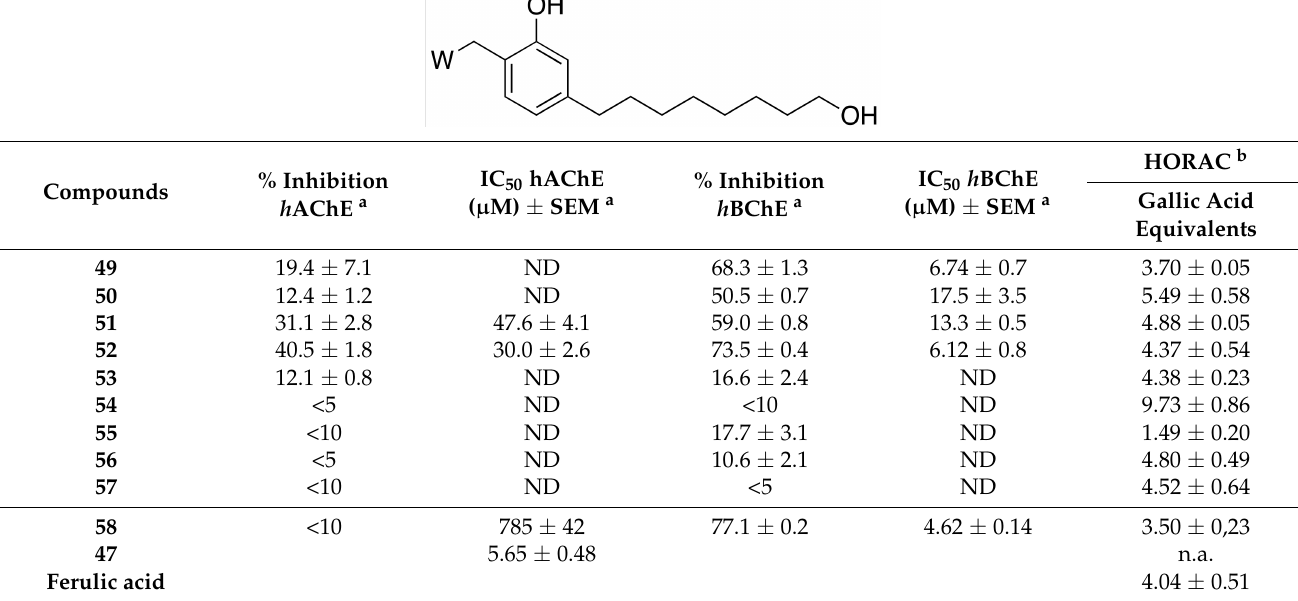
Table 4. Inhibitory activity against AChE and BChE and antioxidant activity of cardanol derivatives 49–58 .